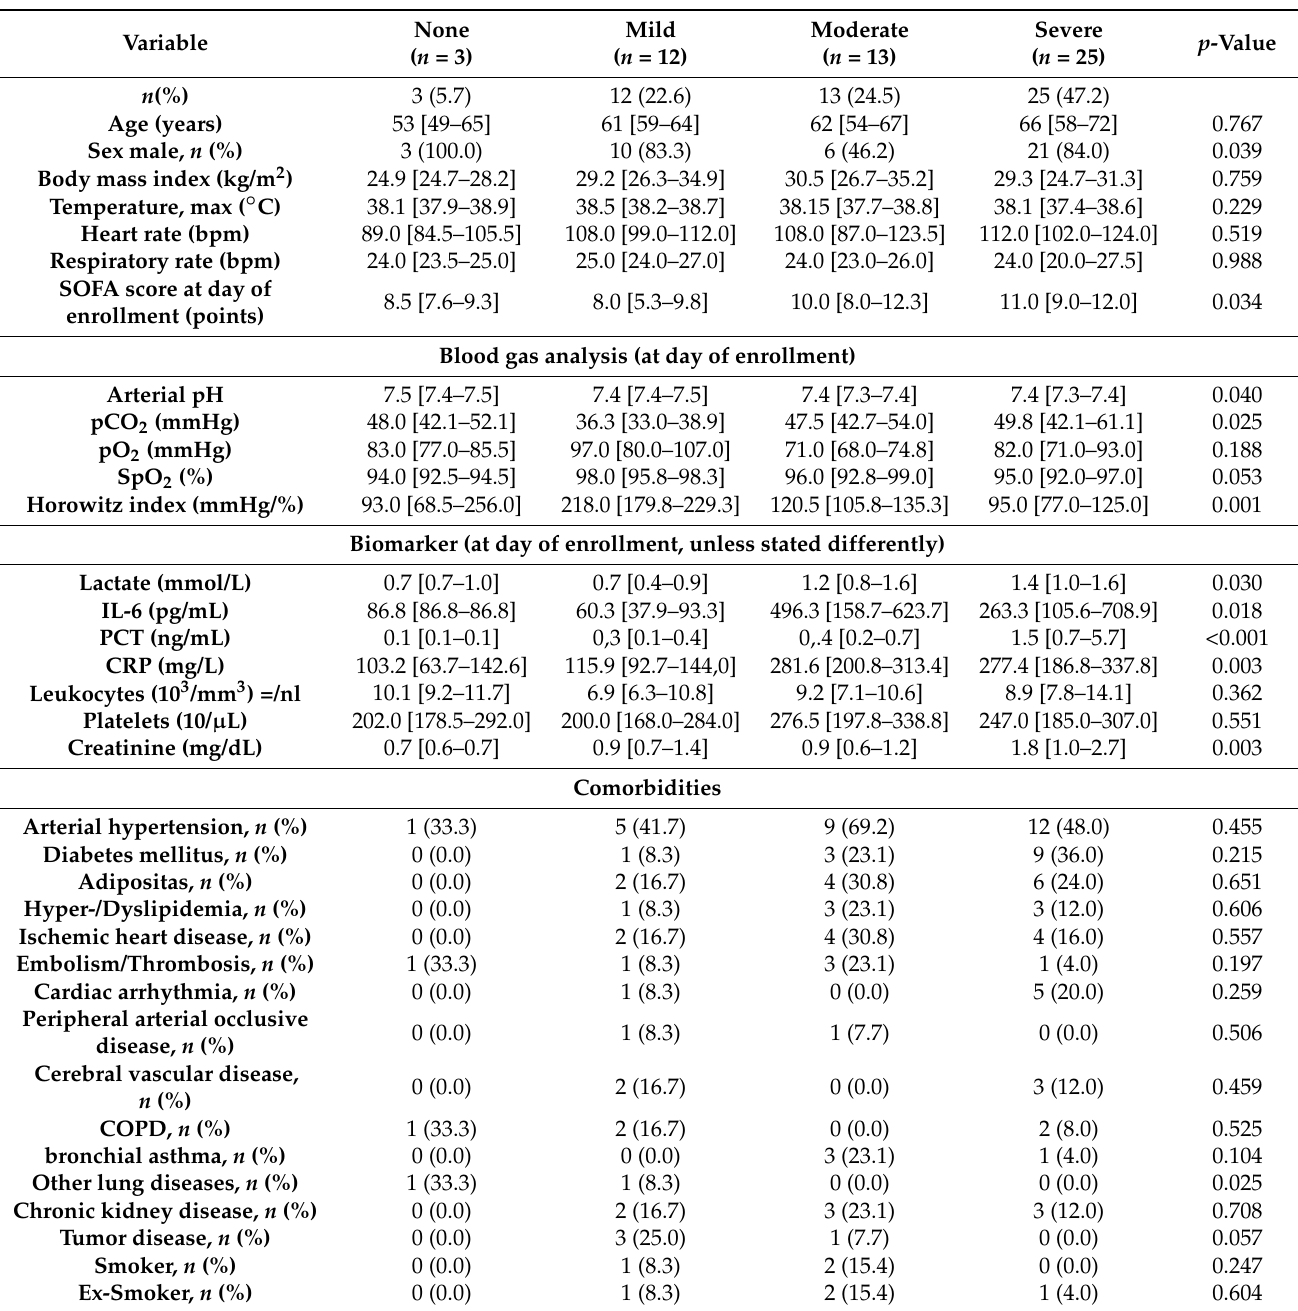
Table 1. Patient characteristics separated by severity of